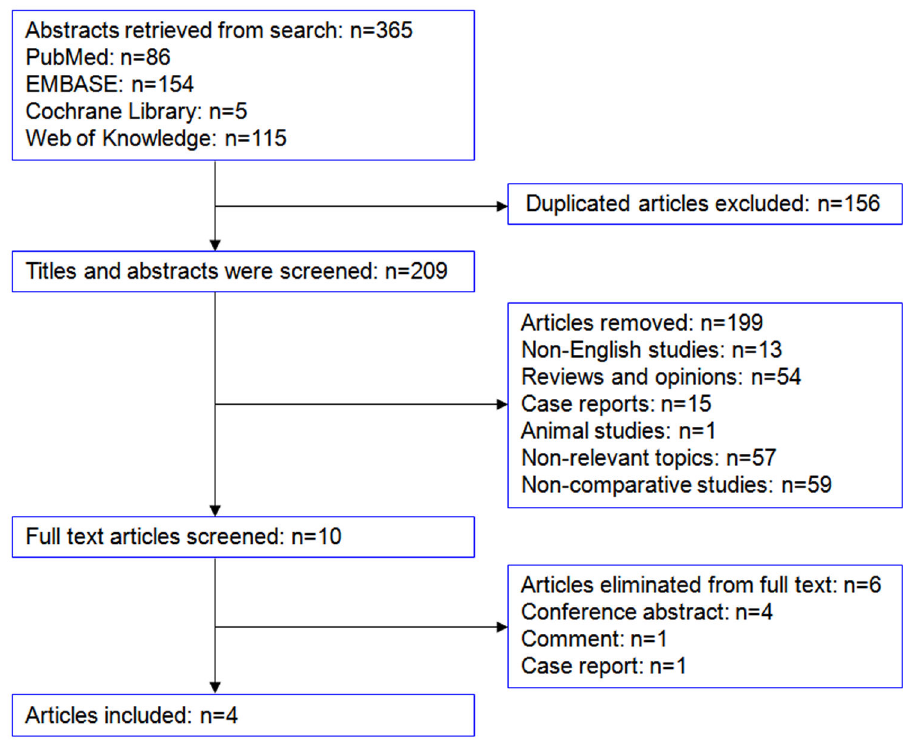
Figure 1. Flow chart of selection.